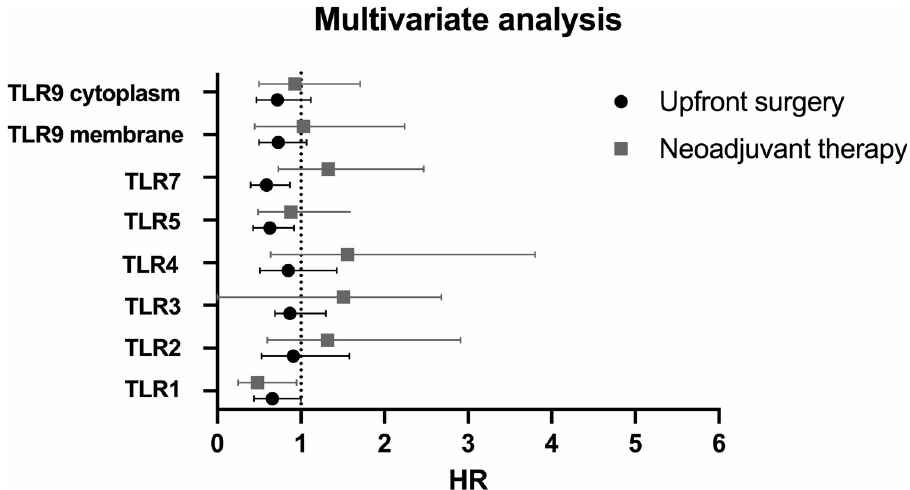
Fig 4. Representation of hazard ratios of the adjusted analysis for each TLR. Every TLR was tested in a separate multivariate analysis for NAT patients and those undergoing upfront surgery separately. Multivariate analysis included age, sex, stage (IA-IIA vs IIB-III), perivascular invasion, adjuvant therapy and TLR expression intensity (high expression vs low expression). X-axis shows calculated hazard ratio with 95% CI. End-point was disease-specific death. HR = Hazards